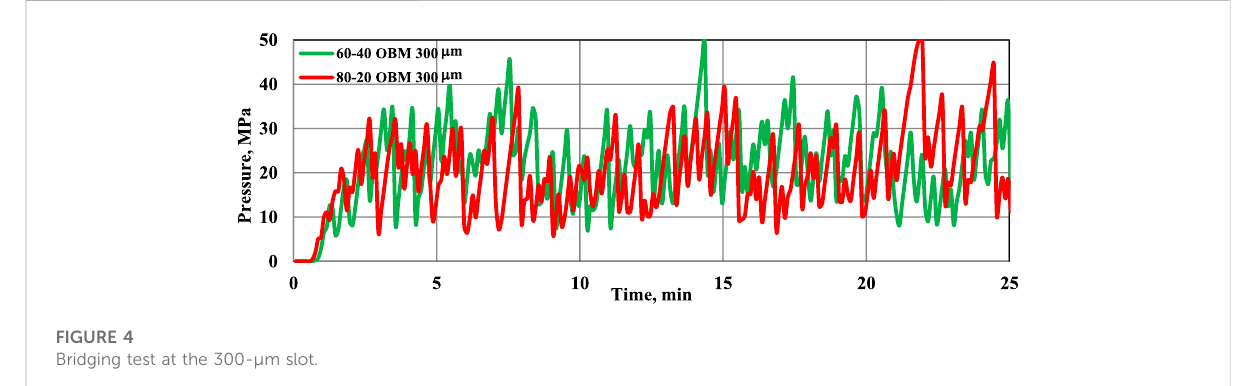
FIGURE 4 Bridging test at the 300- μ m slot.